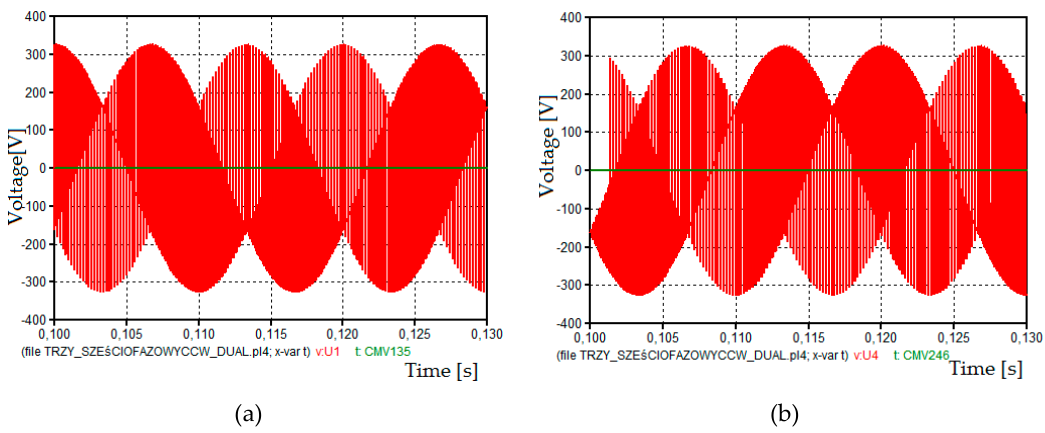
Figure 9. Waveforms of the output voltages (phase 1) (red lines) and the CMV 123 (green colour), ( a ) and waveforms of the output voltages (phase 4) (red lines) and the CMV 246 (green colour) ( b ), synthesized in the MC controlled by the use of the CCW rotating space vectors, for three-phase open-end load and output frequency of 30 Hz. Energies 2018 , 11 , x FOR PEER REVIEW